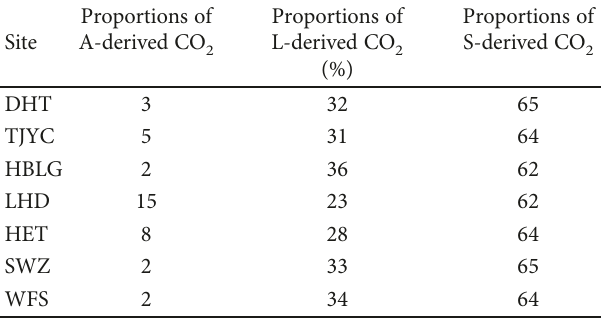
Table 4: Fractional CO the soil